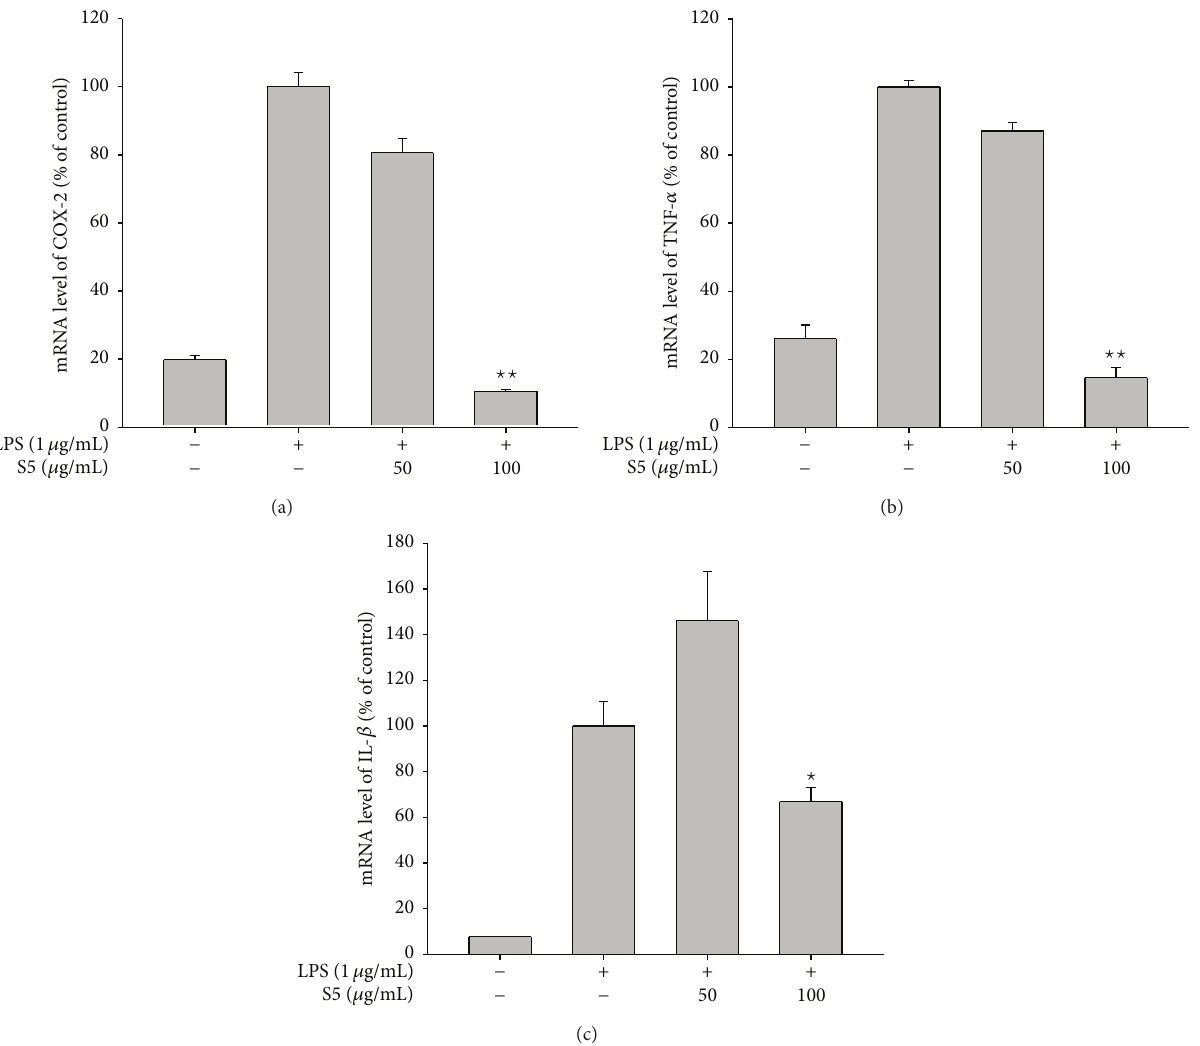
Figure 2: Effects of the S5 peptide on the mRNA expression levels of proinflammatory genes. The mRNA levels of TNF- 𝛼 , COX-2, and IL-1 𝛽 in RAW264.7 cells that had been pretreated with the S5 peptide and stimulated with LPS (1 𝜇 g/mL) for 6 h were determined by real-time PCR. ∗ 𝑃 < 0.05 compared with control